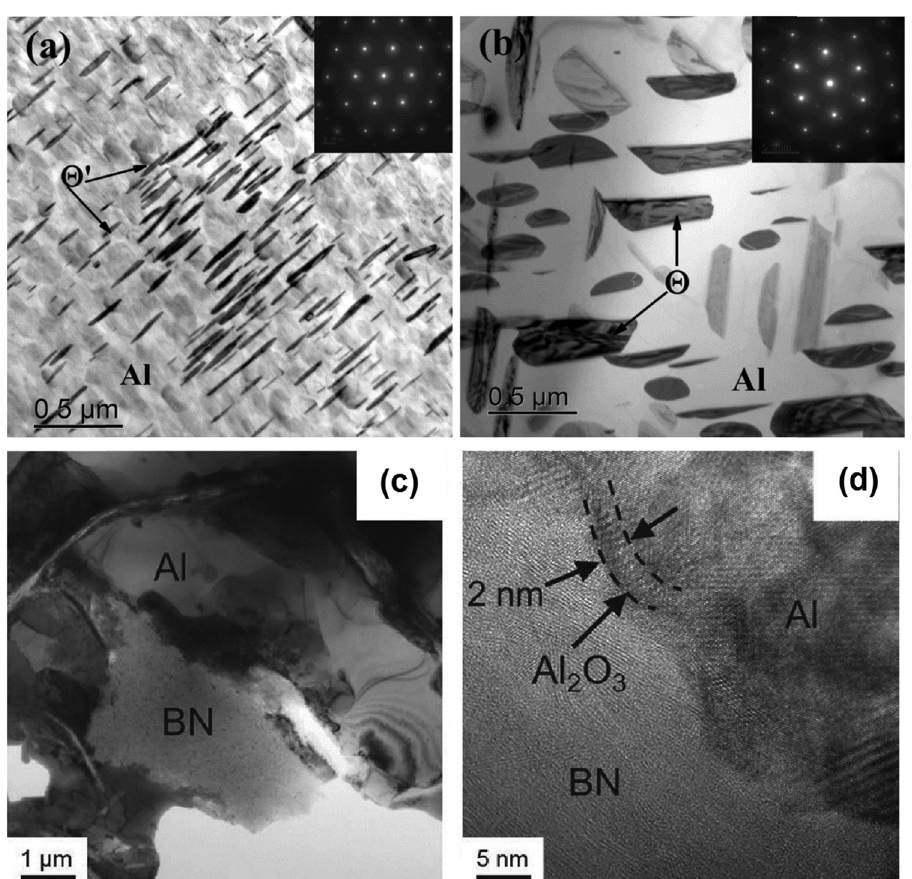
Figure 9: TEM images after aging 9 h at 200°C for: ( a ) an Al – 5% Cu alloy and ( b ) an Al – 5% Cu/5% BN composite. ( Reproduced with permission from [ 157 ] . ) ( c ) TEM image for an Al – 5.3 Cu/3 BN composite and ( d ) HRTEM image of this composite showing an Al/Al 2 O 3 /BN interface ( Reproduced with permission from [ 156 ] . )